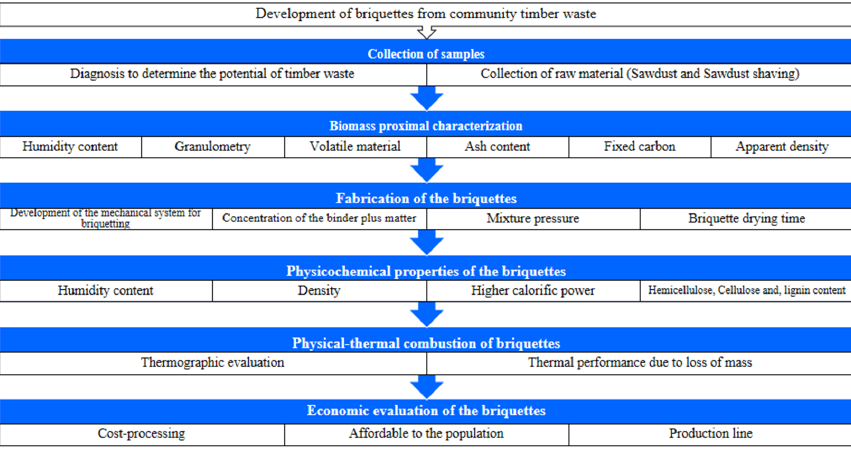
Figure 1. Methodology for making briquettes with wood waste from Pinus